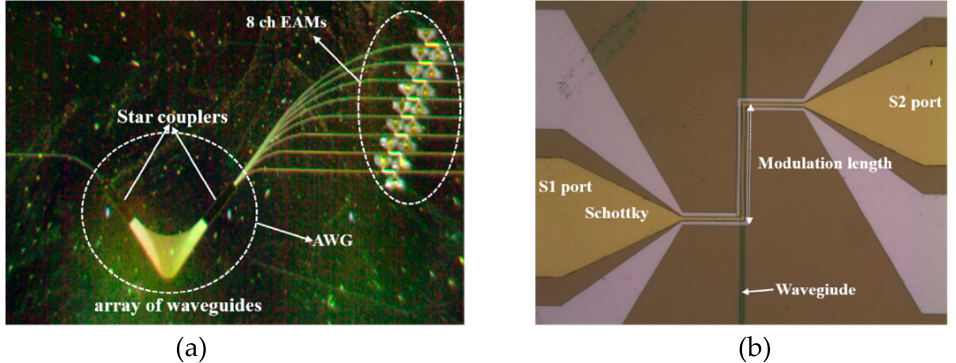
Figure 4. Microscope images of fabricated devices: ( a ) 1 × 8 channel silicon transmitter with EAMs; ( b ) a silicon EAM with a modulation length of 500 μ m.